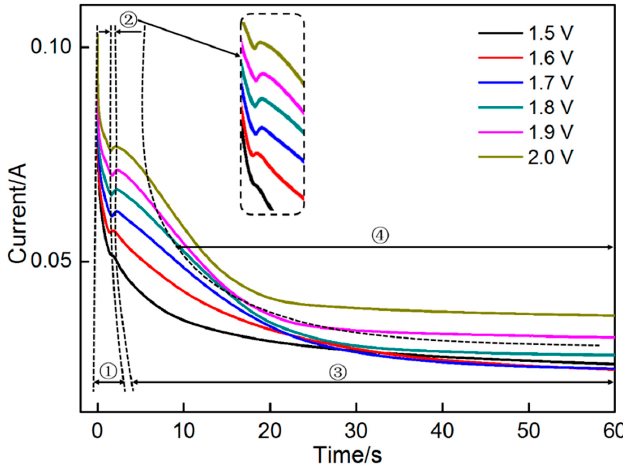
Figure 3. Chronoamperograms obtained on nickel foam.